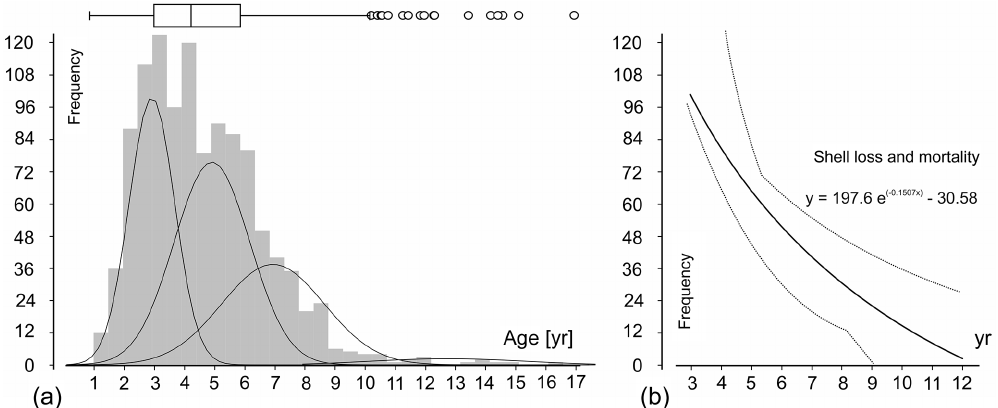
Figure 9. Age–frequency data and box-plot of the shells based on center length data transformed with the von Bertalanffy growth equation. Four cohorts are detected by mixture analysis (a) . Combined effect of natural mortality and shell loss based on an exponential decay equation derived from the amplitudes of detected cohorts (dashed lines represent 95% confidence intervals) (b) .